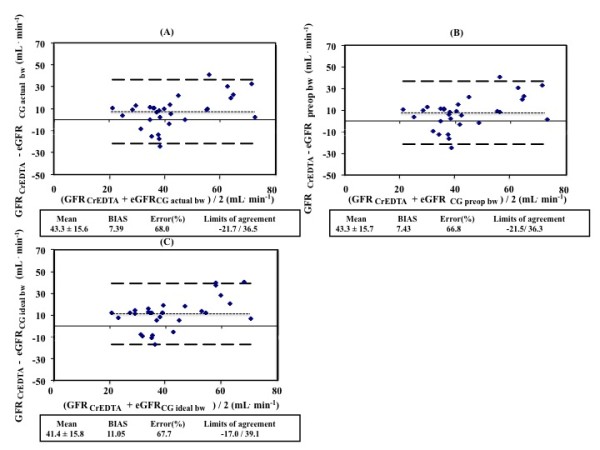
Agreement between measured glomerular filtration rate and estimated rate caluclated using different weights in the CG equation. (A) GFR51 Cr-EDTA and eGFRCG actual bw; (B) GFR51 Cr-EDTA and eGFRCG preop bw; (C) GFR51 Cr-EDTA and eGFRCG ideal bw. bw, body weight; GFR, glomerular filtration rate; GFR51Cr-EDTA, GFR measured with 51Cr-EDTA infusion clearance; GFRCG, GFR estimated with the Cockcroft Gault equation.